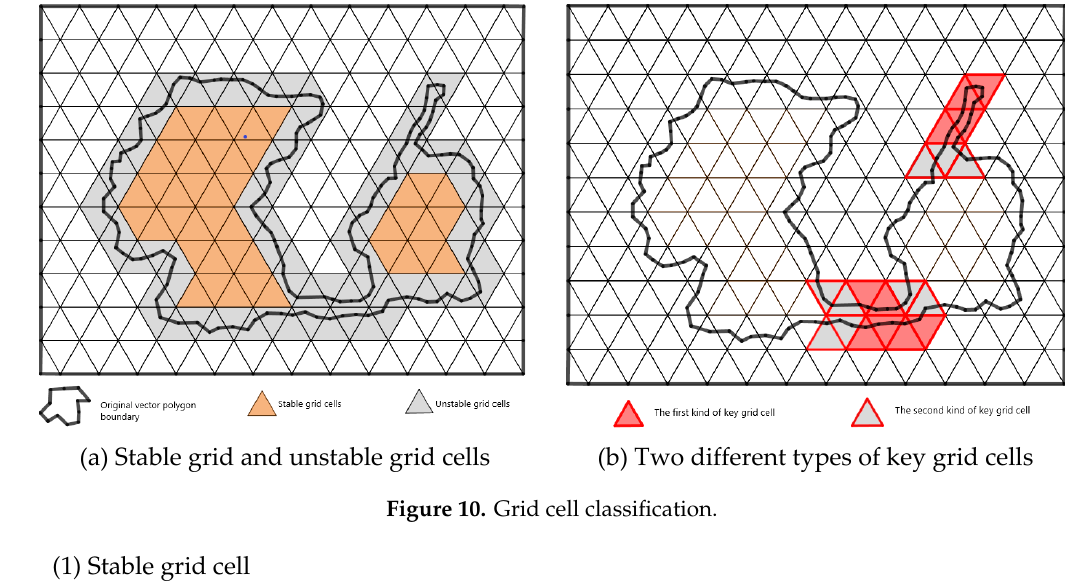
Figure 10. Grid cell classification.